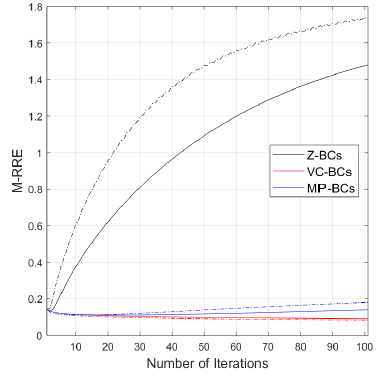
Figure 7. Mean reconstruction error as a function of the number of iterations for deconvolution by Gaussian kernel with σ R = 2.3 and BCs, Z-BCs, VC-BCs, and MP-BCs. The solid line corresponds to standard RL deconvolution ( β = 1), whereas the dashed line is for accelerated RL deconvolution, with β = 2.